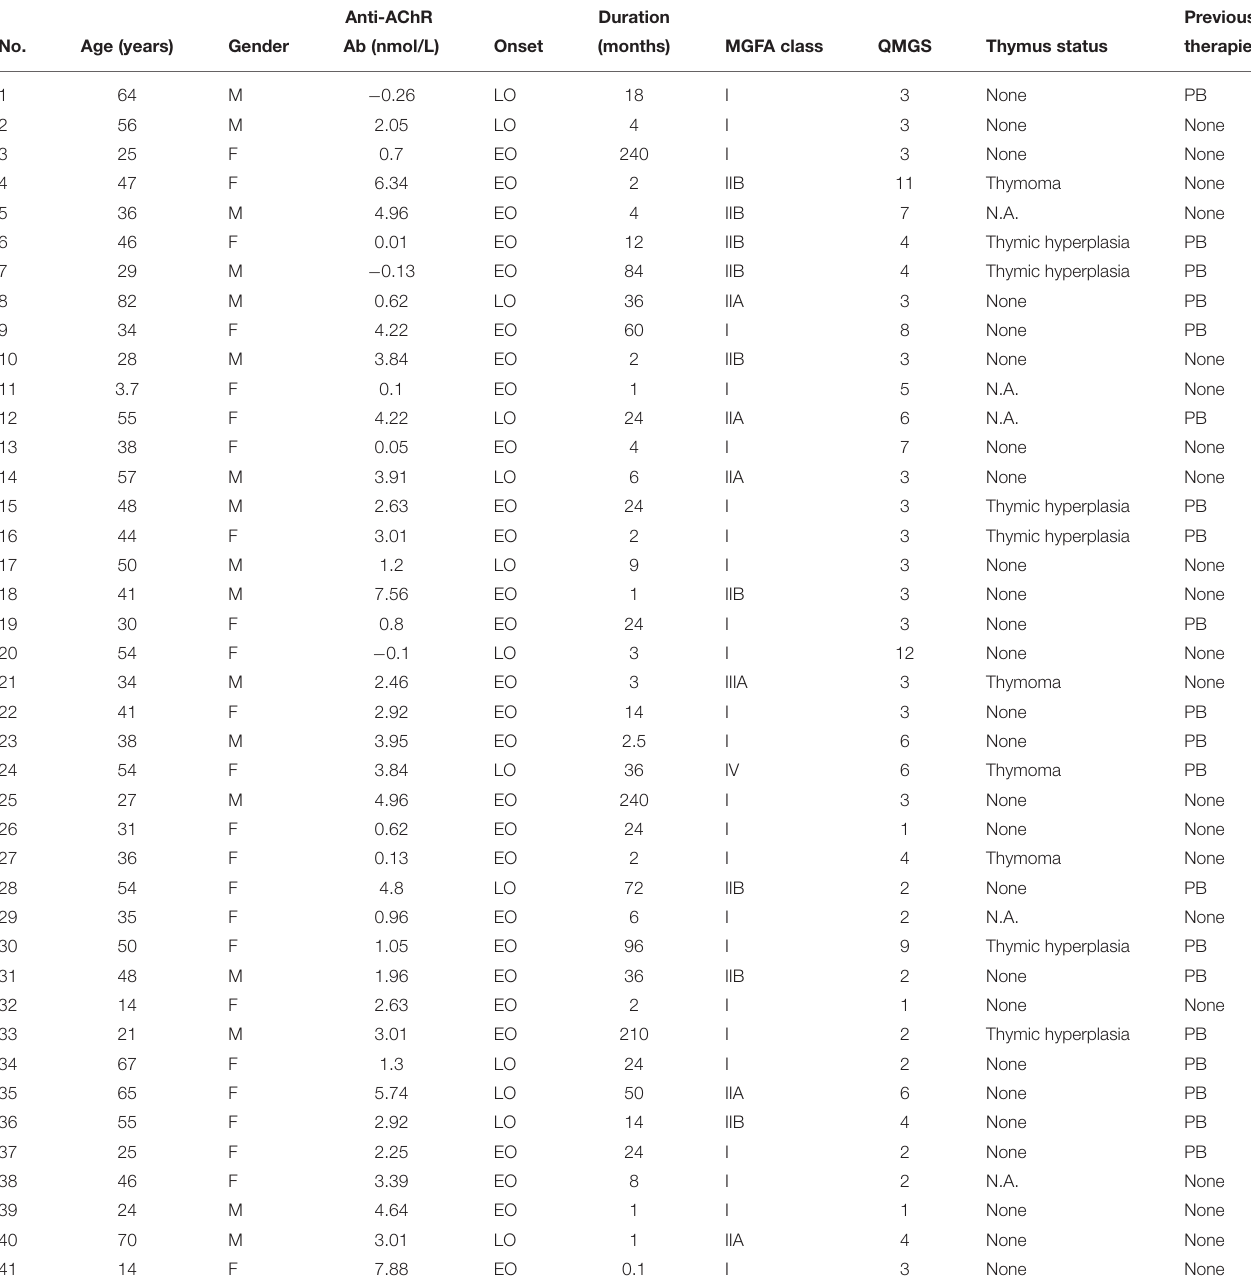
TABLE 1 | Demographics and clinical characteristics of all